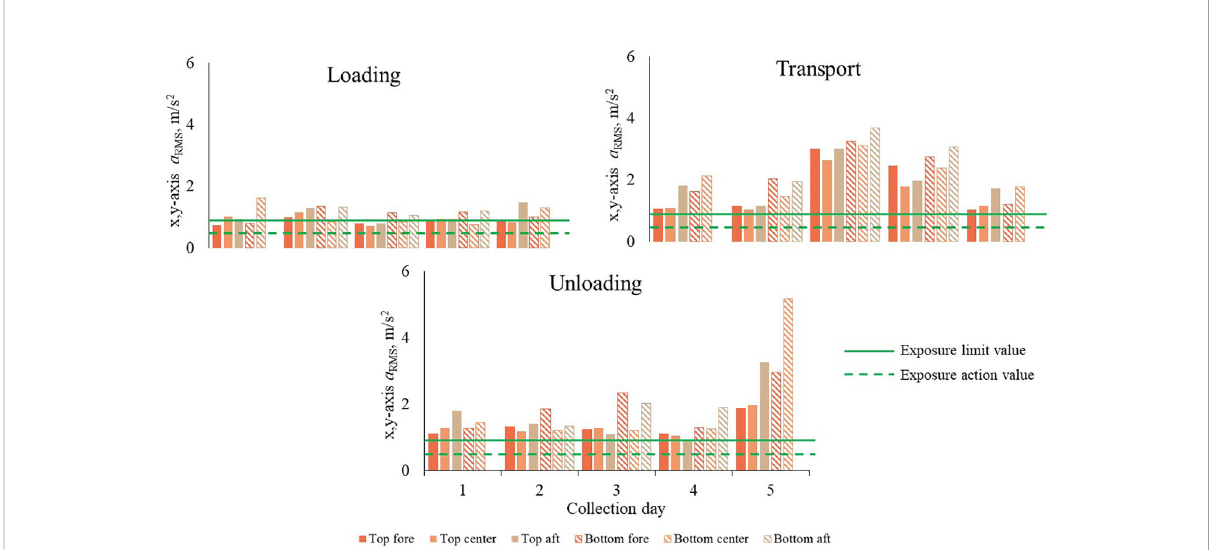
FIGURE 6 x,y-axis root mean square (RMS) experienced by pigs transported within two decks (DEC; T, Top; B, bottom) and three sections (SEC; F, fore; C, center; A, aft) of two trailers during loading (LOD), transport (TRA), and unloading (UDL). Least squares means encompass two daily market-weight